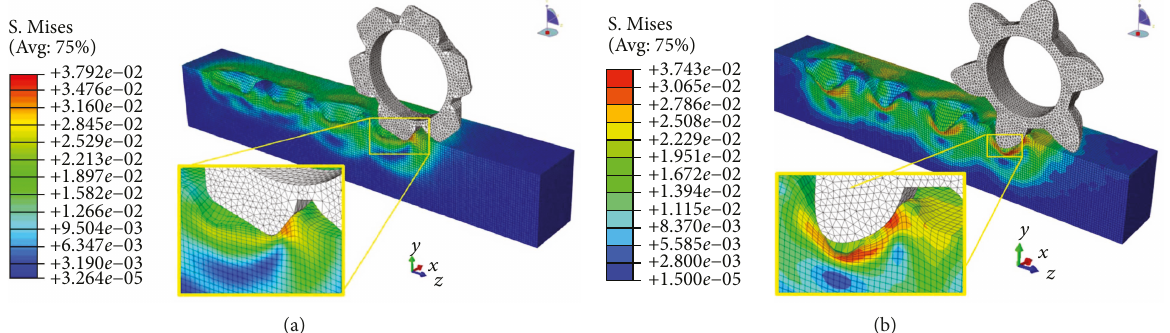
Figure 16: Lifting stage. (a) Conventional toothed wheel. (b) Bionic toothed